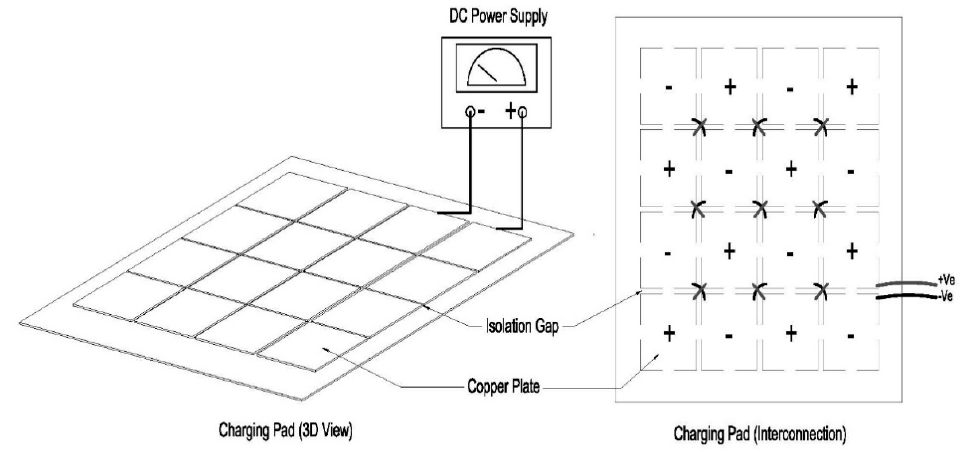
Figure 4. Proposed charging system platform.